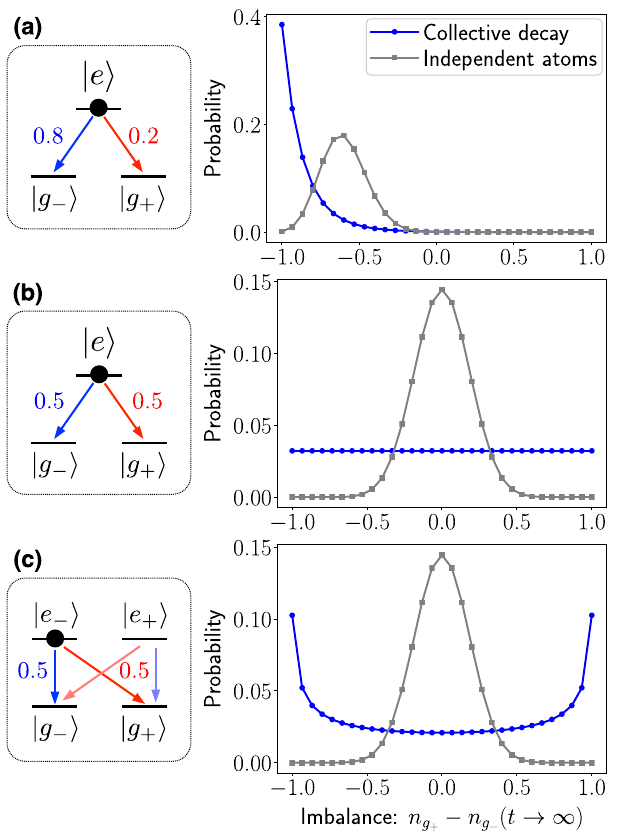
FIG. 17. Final ground-state distributions. Probability distribu- − n tion of the ground-state population imbalance n g þ g − ¼ − ˆ σ at long times t → ∞ computed with ED ð 1 =N Þh ˆ σ g g − g − i þ g þ for N ¼ 30 and different level structures. We show results for collective superradiant decay (blue) as well as for single-particle independent emission (gray). (a) Three-level system composed of ≡ j e ≡ j g 1 = 2 , the j e i states of the F i − 1 = 2 i V and j g (cid:2) i V g ¼ (cid:2) 1 = 2 V V 3 = 2 level structure. (b) Three-level system composed of the F e ¼ ≡ j e ≡ j g F states of the F j e i i − 1 = 2 i V and j g (cid:2) i V g ¼ e ¼ (cid:2) 1 = 2 V V 1 = 2 . In 1 = 2 level structure. (c) Four-level system with F F g ¼ e ¼ each panel, we give the single-particle decay probabilities ˆ Π − ˆ Σ − corresponding to (blue arrows) and (red